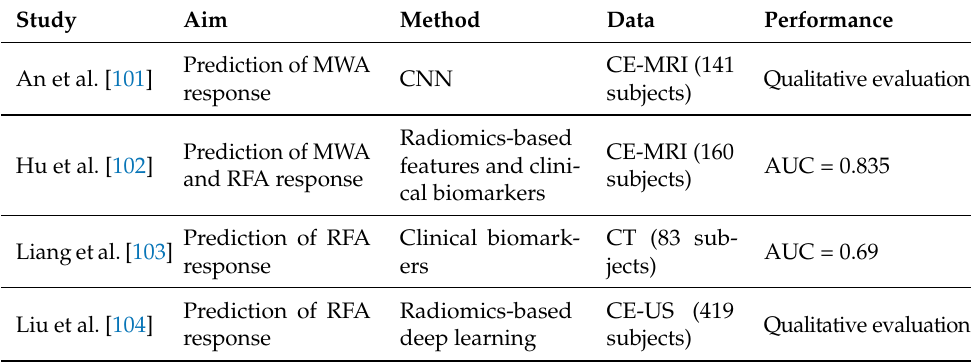
Table 5. Prediction of response to ablation therapy (MWA and